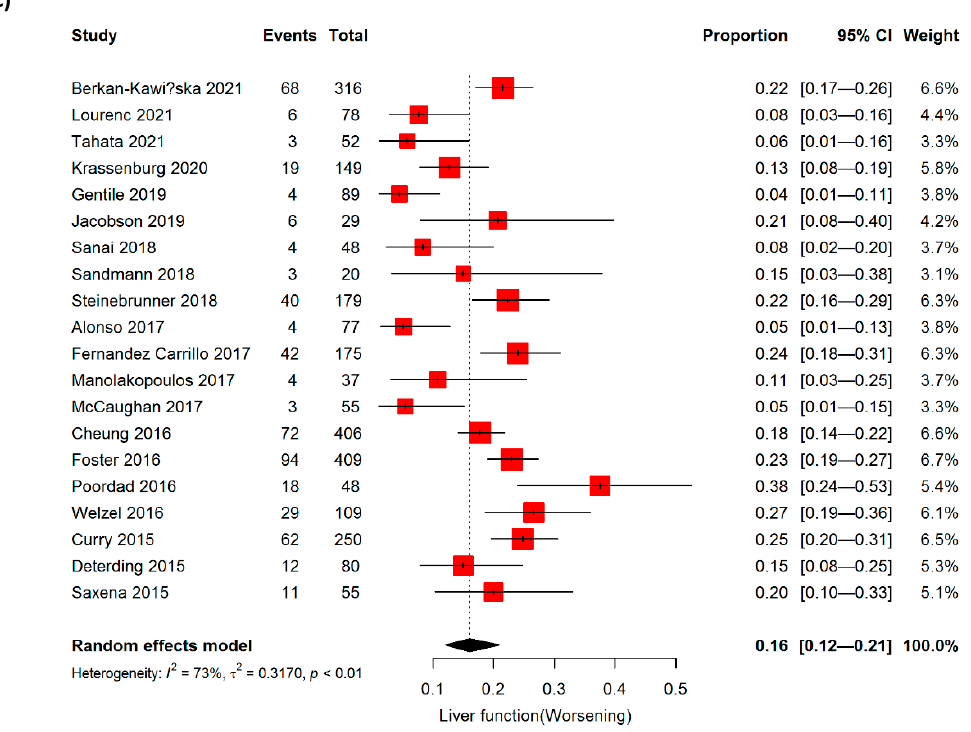
Figure 3. Estimated event rate of ( A ) improvement in liver function, ( B ) delisting from liver trans- plantation, and ( C ) worsening in liver function of decompensated liver cirrhosis patients treated with direct-acting antiviral (DAA).